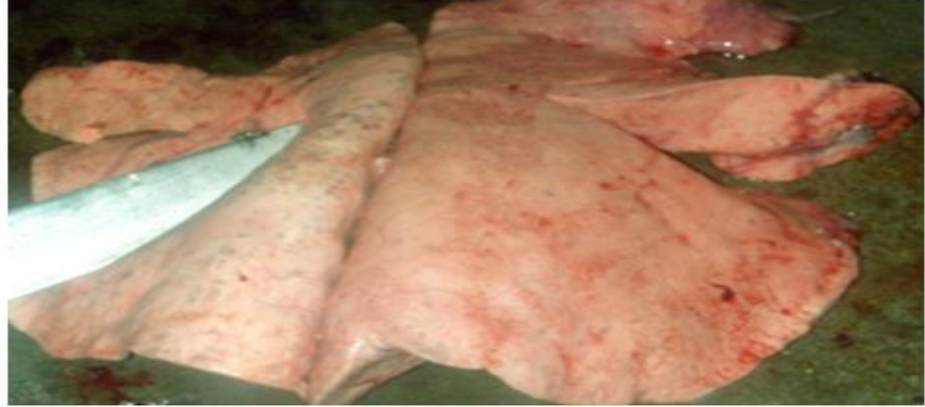
Figure 9. Strongylosis (Candle stains).